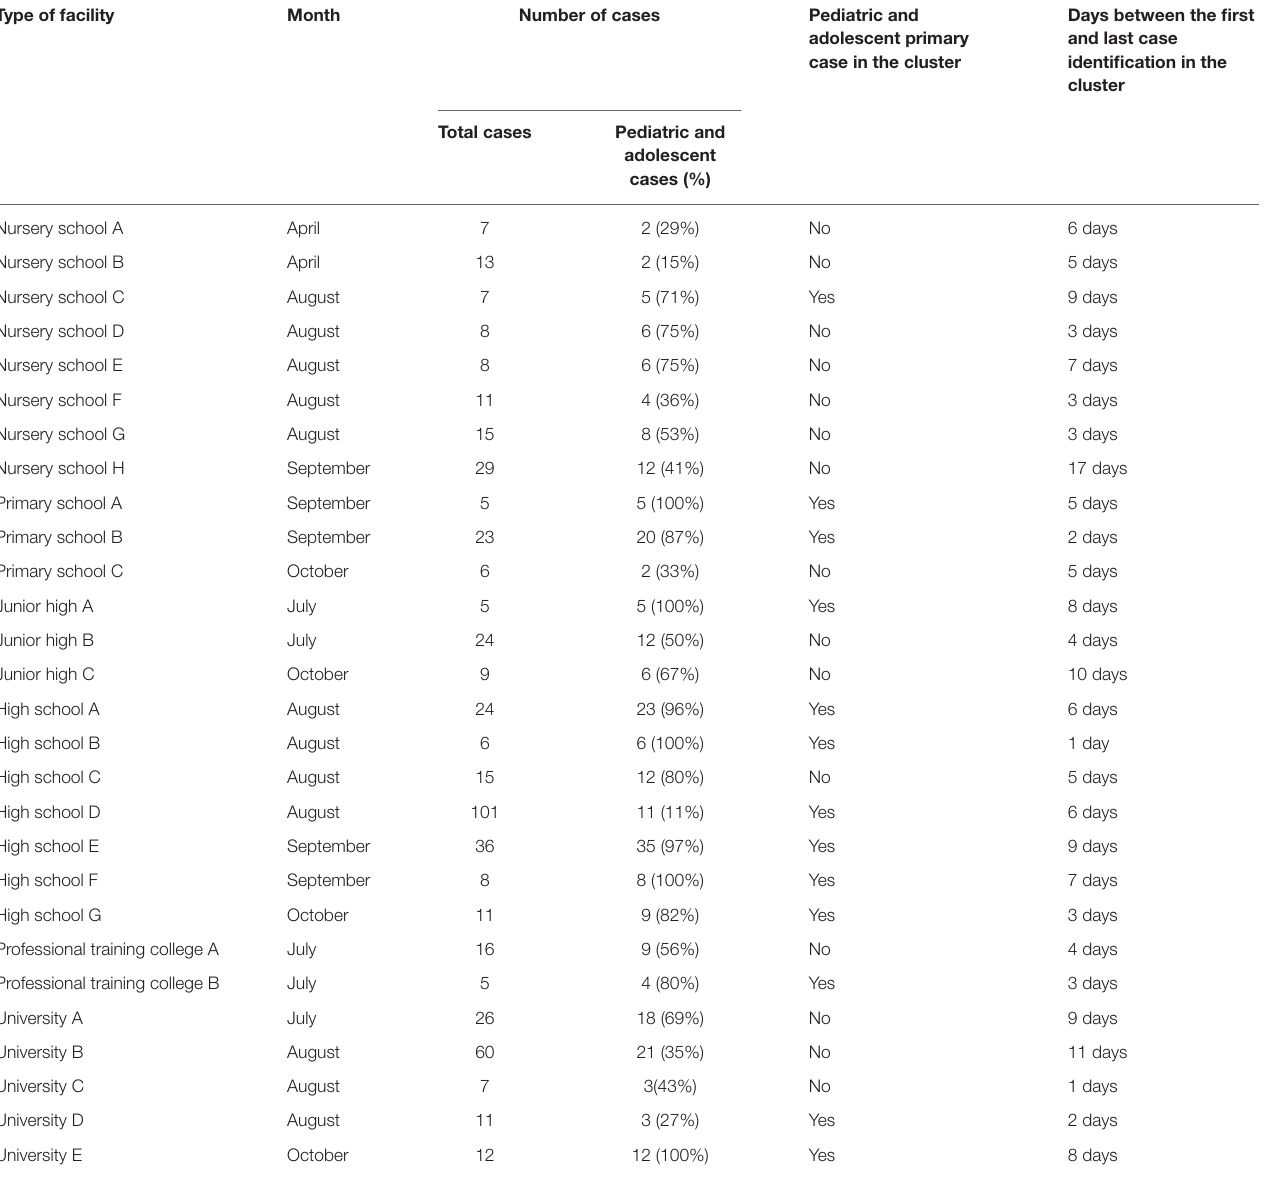
TABLE 3 | COVID-19 clusters in Nursery schools and schools in Japan, from January 15 to October 31,